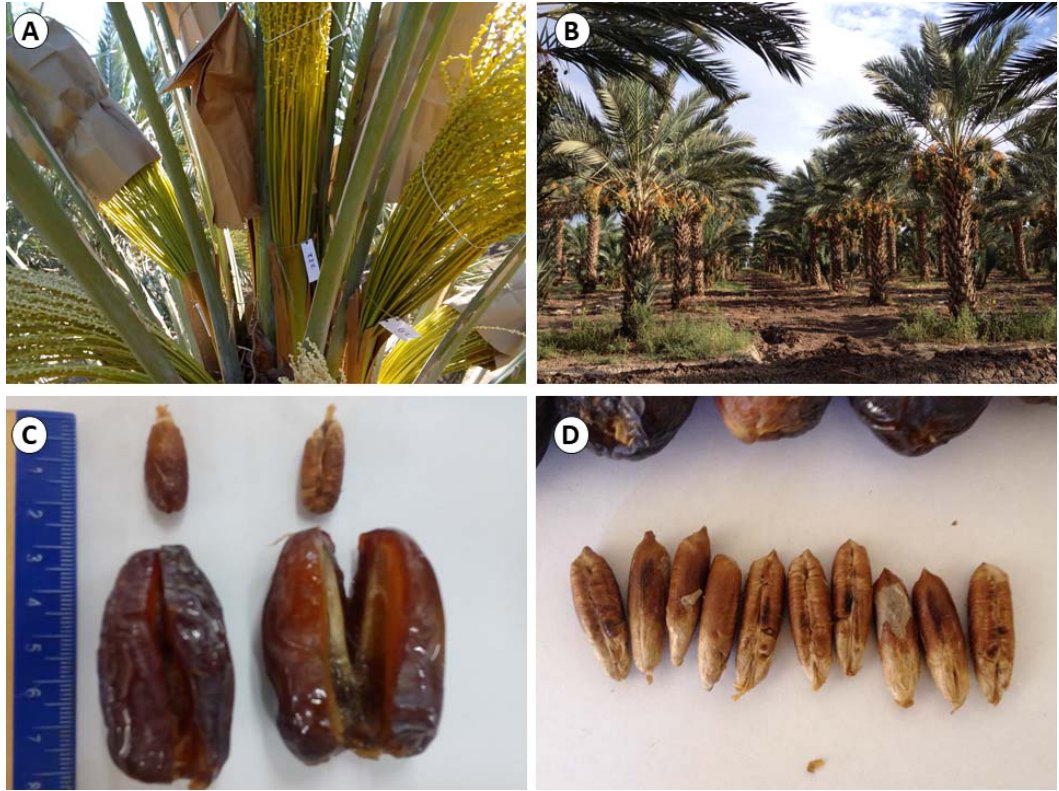
Figure 1. Experimental area and seed extraction. ( A ) Female inflorescences covered with paper bags after pollination to avoid contamination with other pollen sources. ( B ) Panoramic view of the plantation 50 days after pollination. ( C ) Removing the seed of the ripe fruit. ( D ) Sample of seeds extracted from the pollinated fruit with the ‘Zahidi’ pollen source.